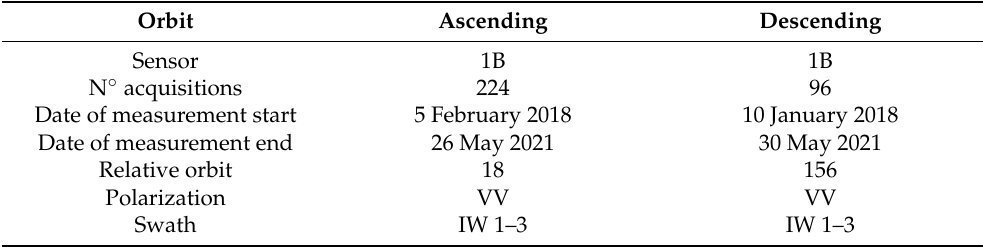
Table 1. Sentinel-1 data set, including the main features of SLC products used. Orbit Ascending Descending